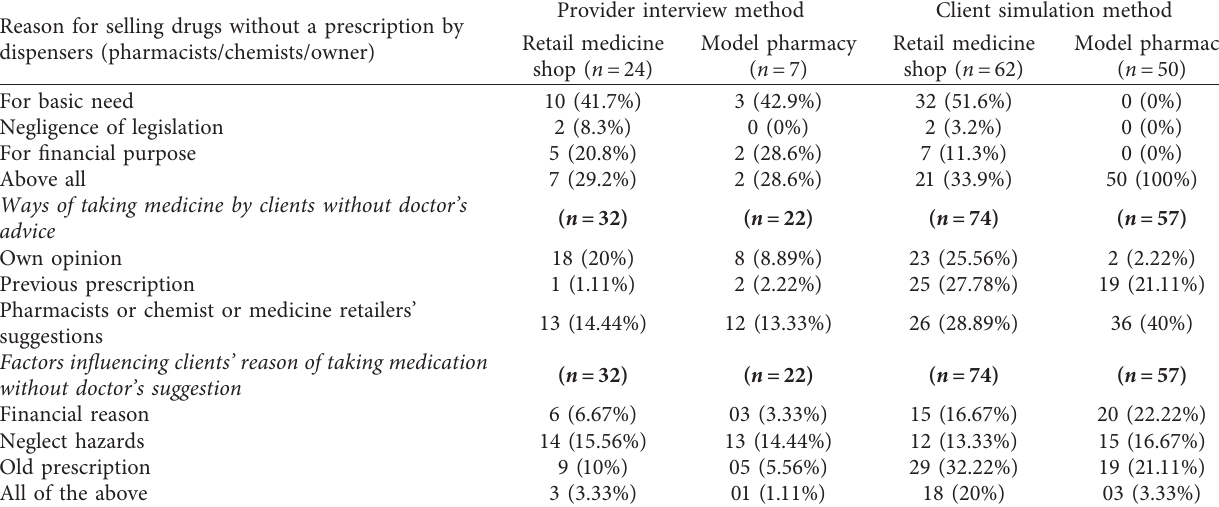
Table 5: Underlying reasons for selling and buying medicines without a